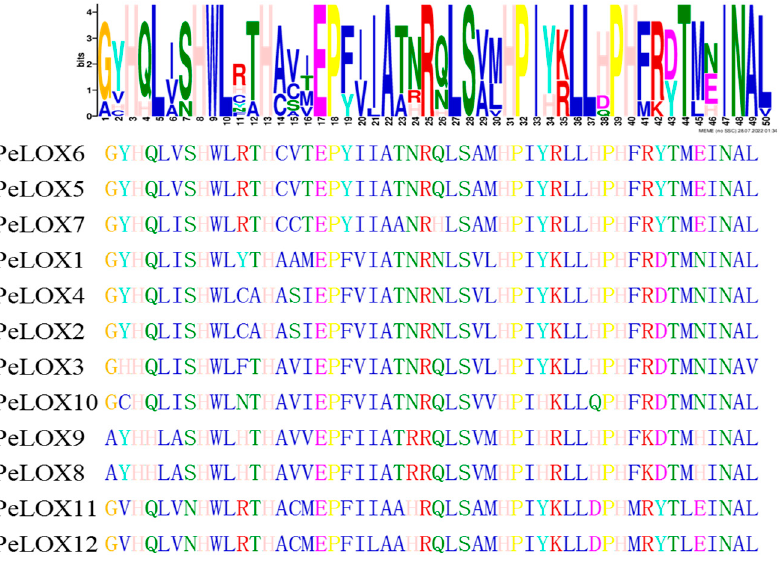
Figure 4. Sequence alignments of a conservative motif His-(X) 4 -His-(X) 4 -His-(X) 17 -His-(X) 8 -His in LOX proteins of passion fruit.